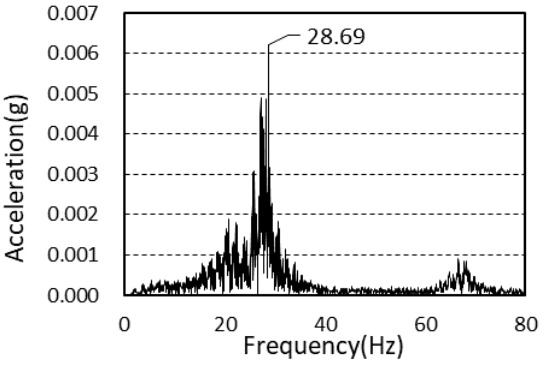
Figure 6. Power spectrum (framing completion).